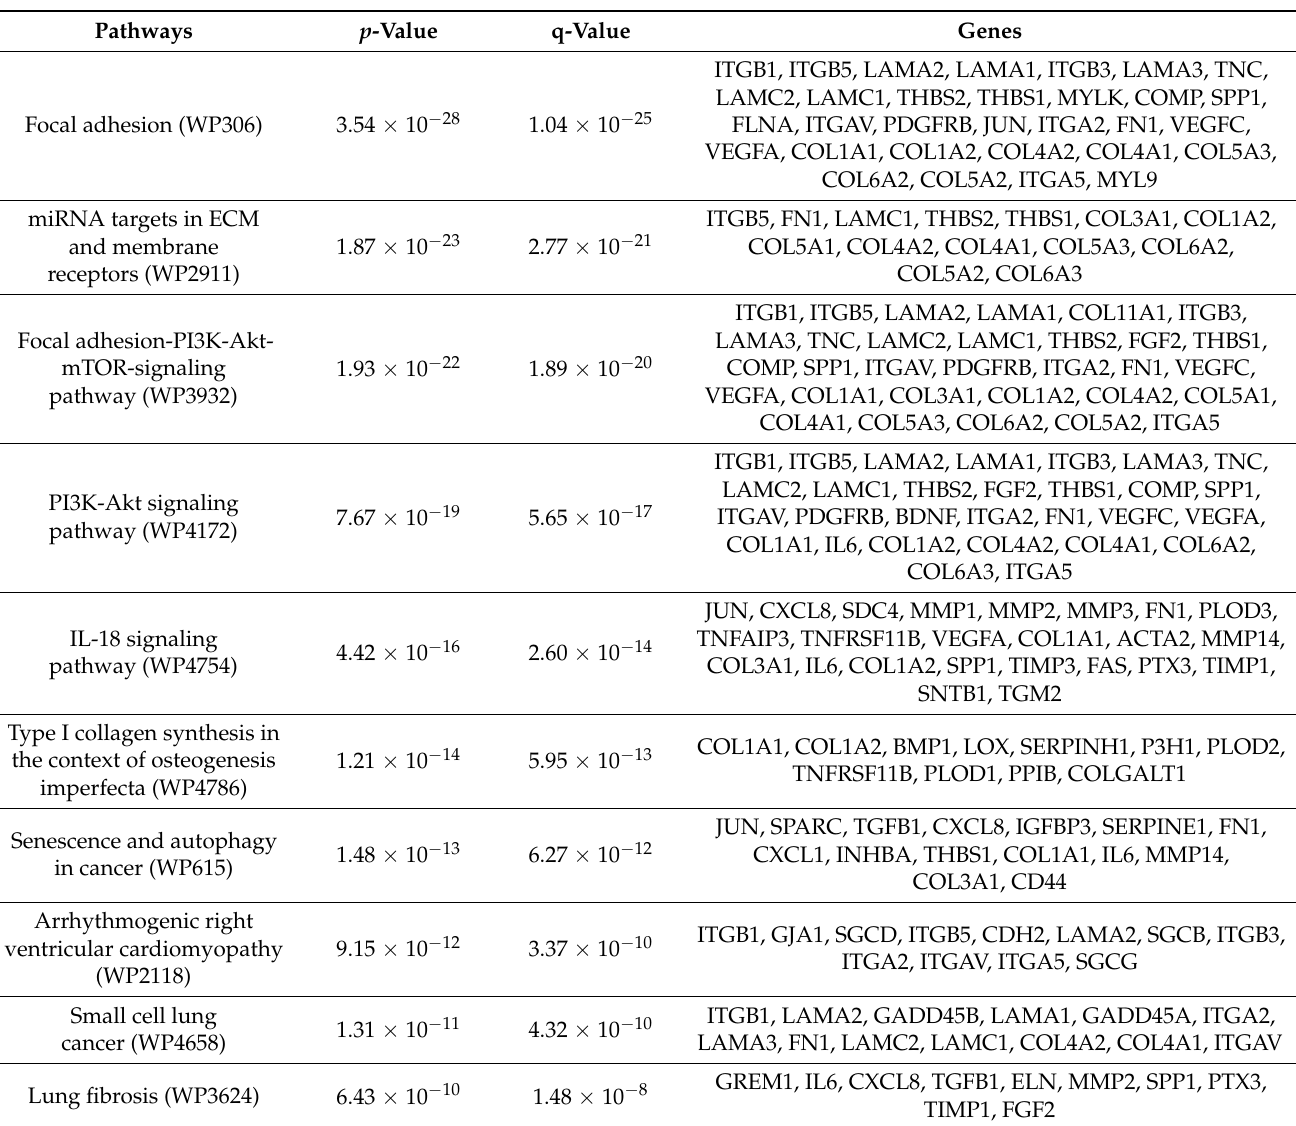
Table 1. Common genes and pathways in correlation between B4GALT1 and